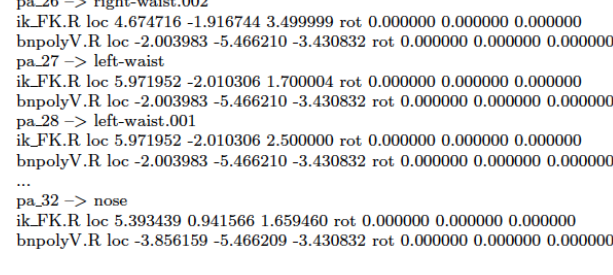
Figure 6 – Example of Pose library for Location.